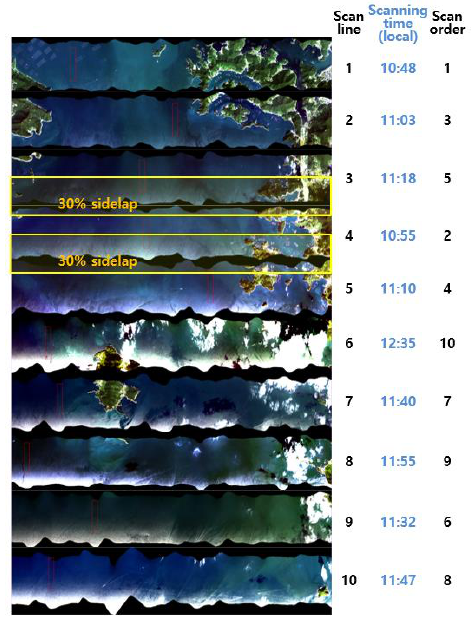
Figure 3 . Hyperspectral scanning images for each scan line and scanning order and time information for capturing images.